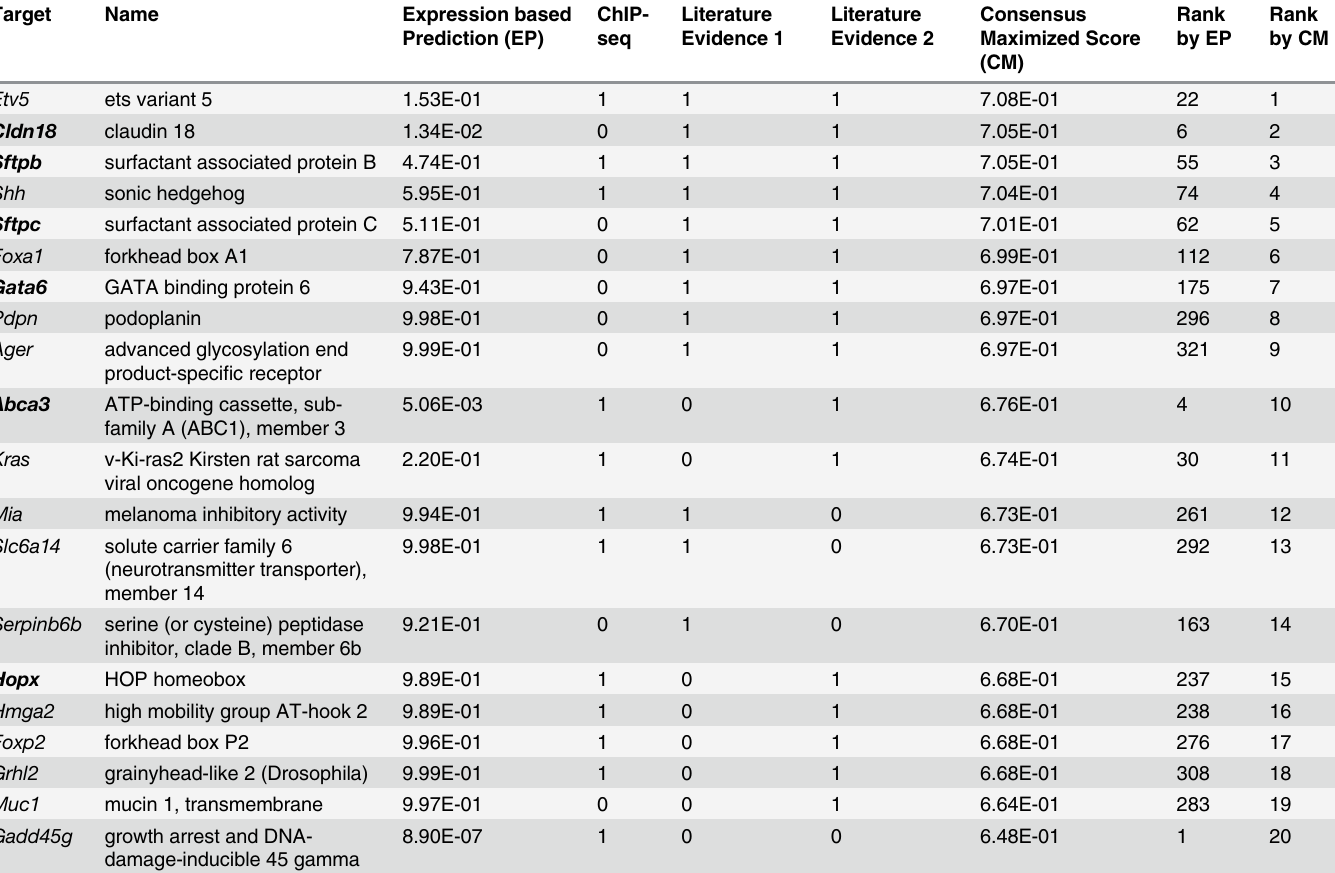
Table 2. Top 20 Predicted Regulatory Targets of Nkx2-1 Identified from a Consensus among Expression based Prediction, ChIP-seq, and Litera- ture